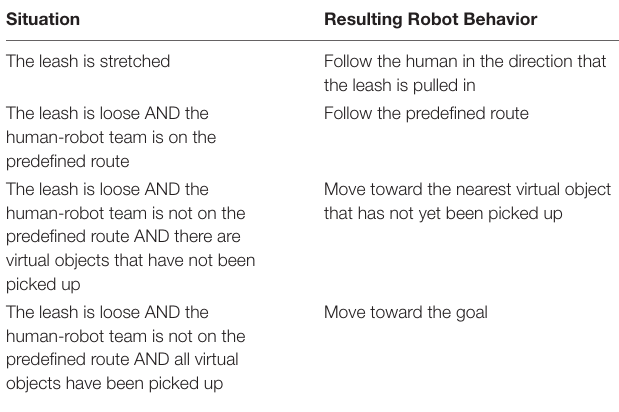
TABLE 3 | The protocol used by the human operator to control the behavior of the